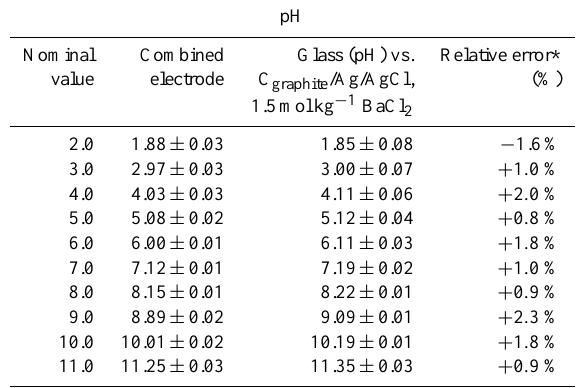
Table 2. pH measured using a glass electrode against an all-solid- state reference electrode containing 1.5molkg − 1 BaCl 2 at room temperature. pH Nominal Combined Glass (pH) vs. Relative error*